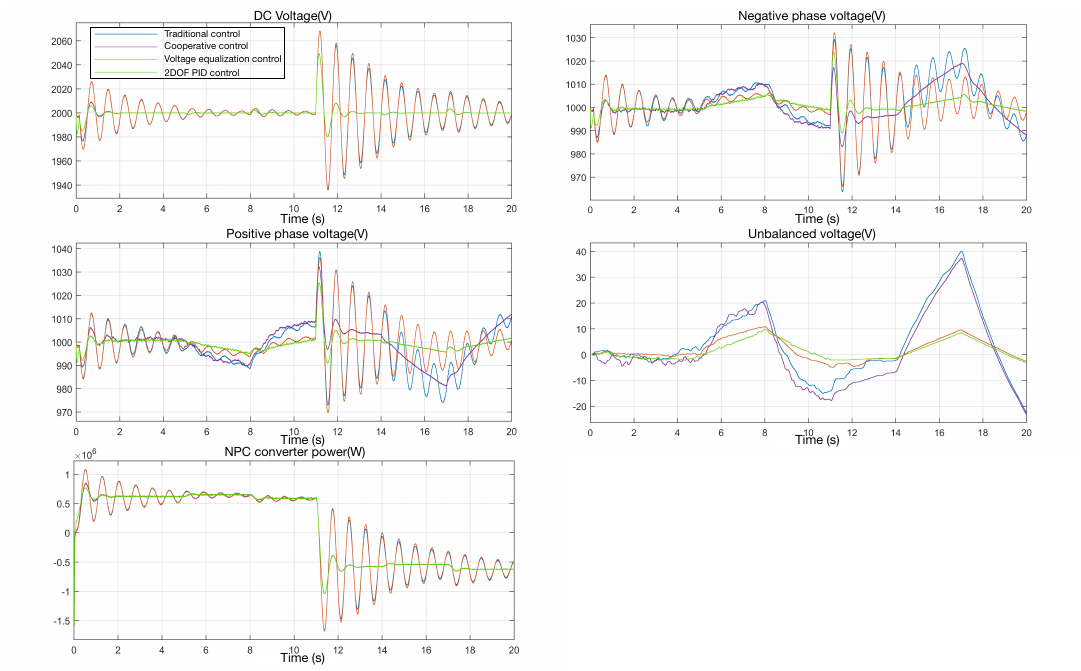
Figure 17. Simulation of synthetic